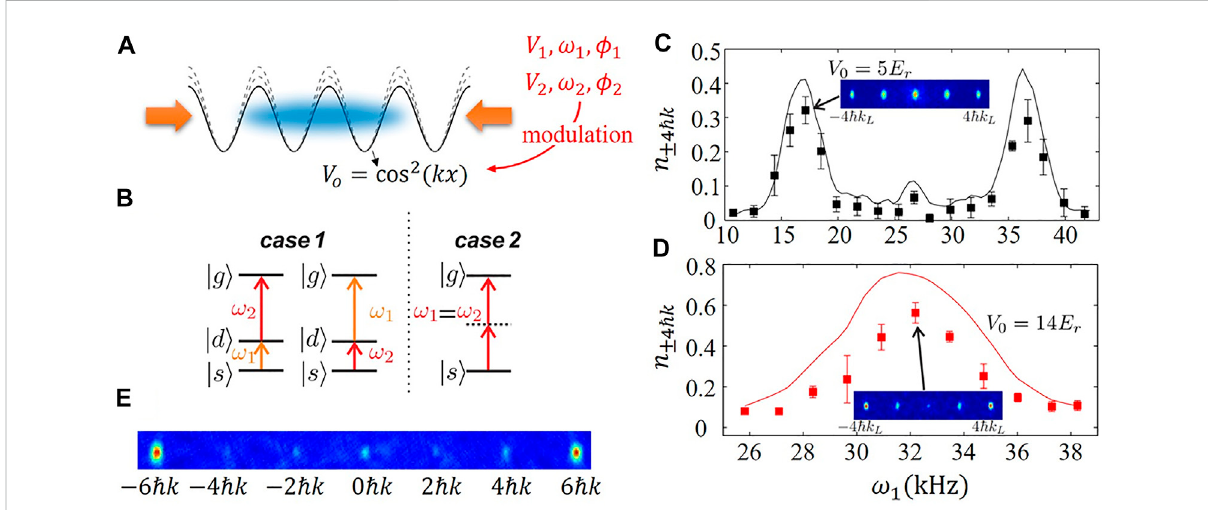
FIGURE 7 (A) Schematic diagramofthepolychromatic amplitude modulation lattice. (B) Twospecial cases indetecting the transferpopulationspectrum. In case 1, absorption of photons with ω 1 or ω 2 is resonant with D-band. In case 2, two frequencies are equal. Spectrum for the population on ± 4 Z k stateswithincreasingofmodulationfrequency ω